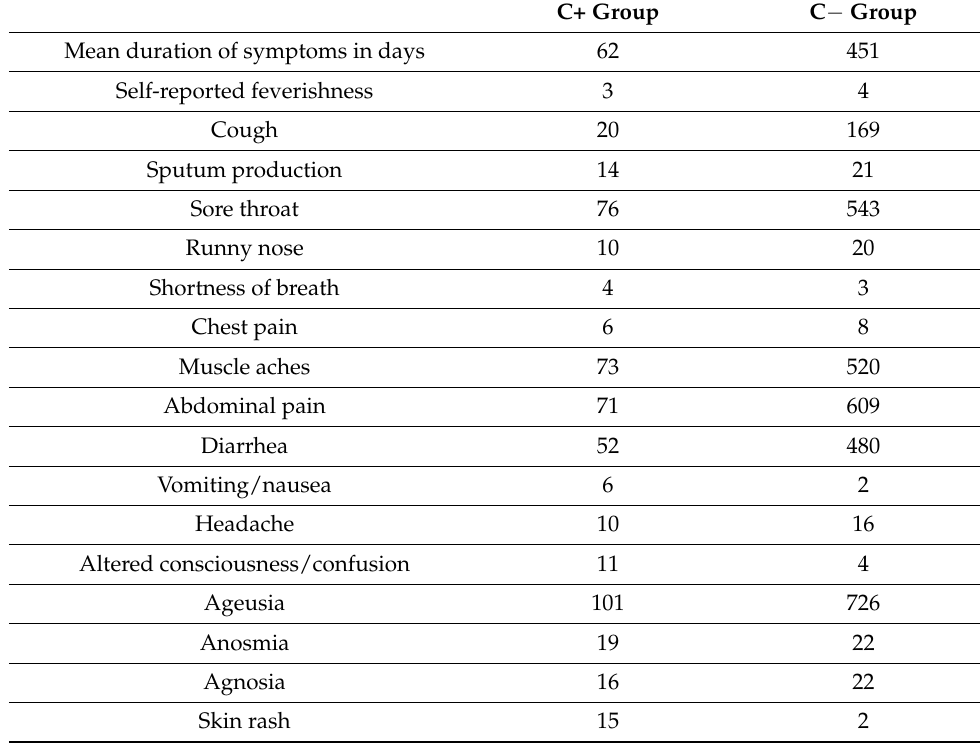
Table A2. Description of missing data by variable in Table 3.